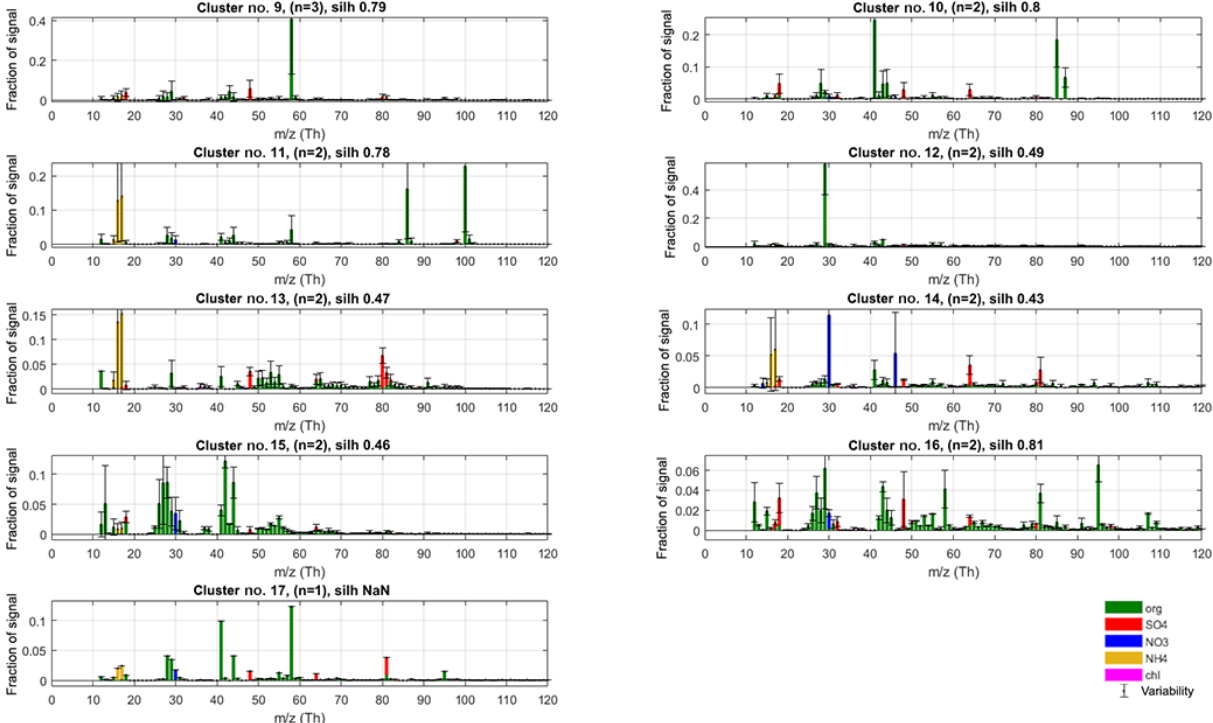
Figure 12. Spectra of outlier clusters (no. 9 to no. 17) for P-I. The spectra for these outlier classes were omitted from our analysis due to not meeting the criteria of (1) occurrence and/or (2) interpretability (on an acceptable level). Despite their mostly speculative value, many of them feature some chemically interesting characteristics, potentially pointing to the presence of amines (signals at m/z 58, 86 and 100 Th; clusters no. 9, no. 11 and no. 17), alkali metals ( 85 Rb, 87 Rb; no. 10), cycloalkanes (signals at series m/z 69, 79, 81, 95, 107 and 109 Th; no. 16) and organic sulfate (signal at m/z 80, 81 Th; no. 13, no. 17), as well as effects of surface ionisation ( 41 K + ; 39 K +++ ; no. 10, no. 17) and a likely artefact from poor air-beam correction (signal at m/z 29 Th; no.